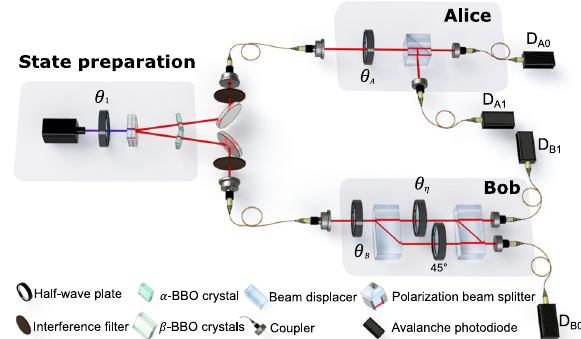
Fig. 1 Experimental setup. Desired quantum states are generated via type-I spontaneous parametric down-conversion using two joint β -Barium Borate (BBO) crystals. In the measurement stage, a half- wave plate (HWP) at θ A and a polarizing beam splitter (PBS) on Alice ’ s side perform the perfect projective measurement. For Bob ’ s side, a POVM is performed by an HWP at θ B and a Mach – Zehnder interferometer with two beam displacers (BDs) and two HWPs at θ η and 45 ∘ inserted in each arm of the interferometer, respectively. For the second scenario, BDs and two HWPs are removed from the setup and an HWP at θ B is used to perform a projective